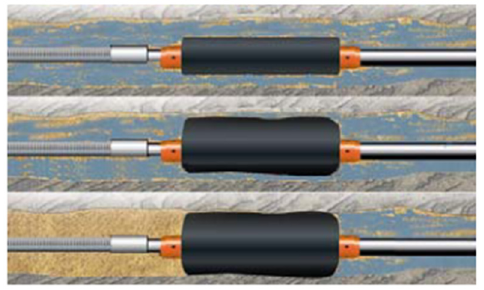
Figure 17. Elastomer swelling creates interzone isolation.